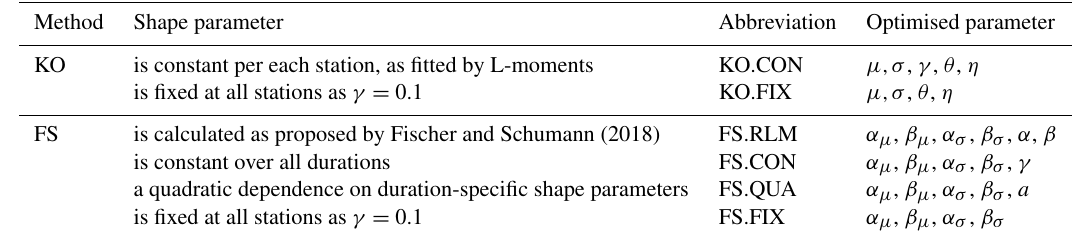
Table 5. A review of the methods and the different calculation of the shape parameter investigated for the local statistics, where KO stands for Koutsoyiannis and FS for the Fischer and Schumann